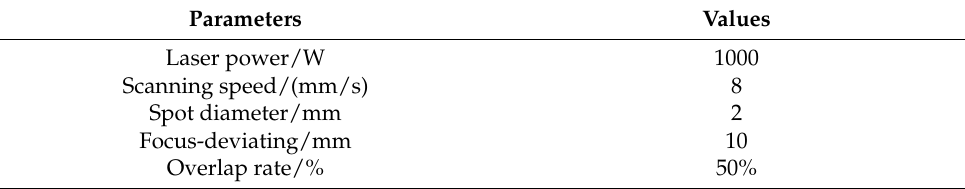
Table 2. Laser cladding process parameters. Parameters Values Laser power/W 1000 Scanning speed/(mm/s) 8 Spot